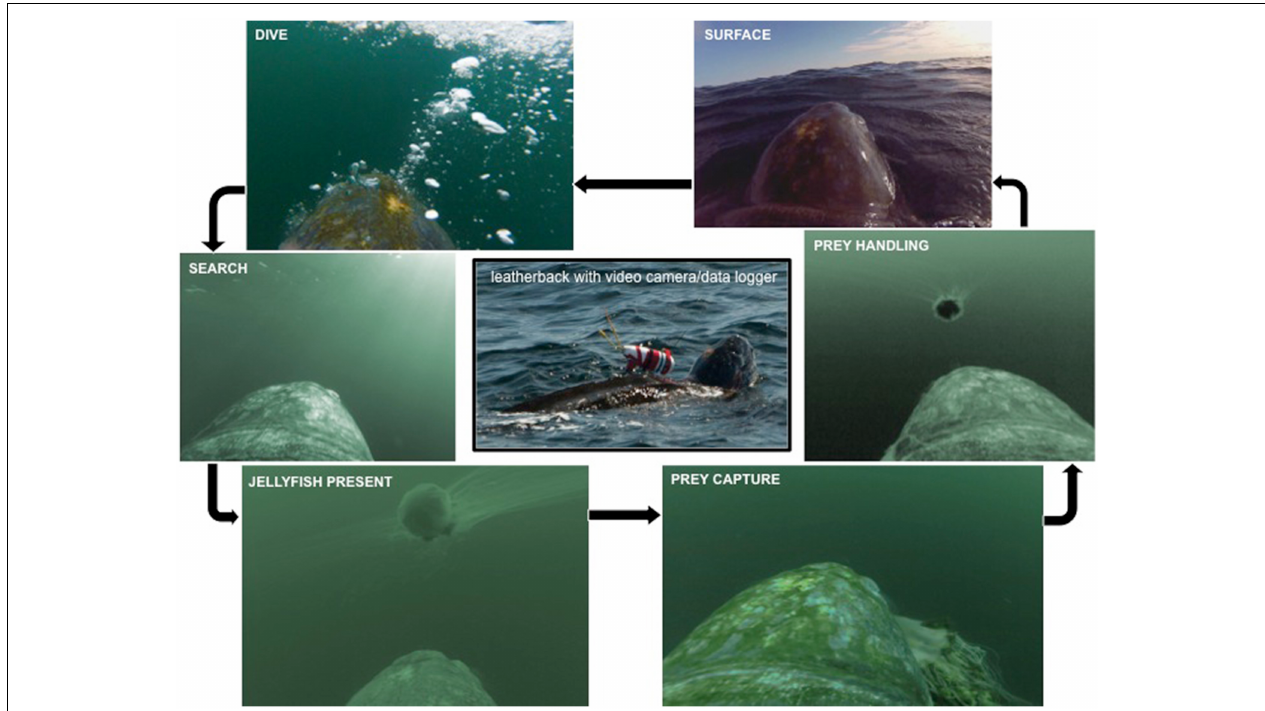
FIGURE 2 | Schematic of a typical dive cycle with prey capture using images from turtle-borne video footage. Starting in the upper right and moving counter-clockwise; surface: turtle at the surface breathing and resting between dives; dive: bubbles denote turtle